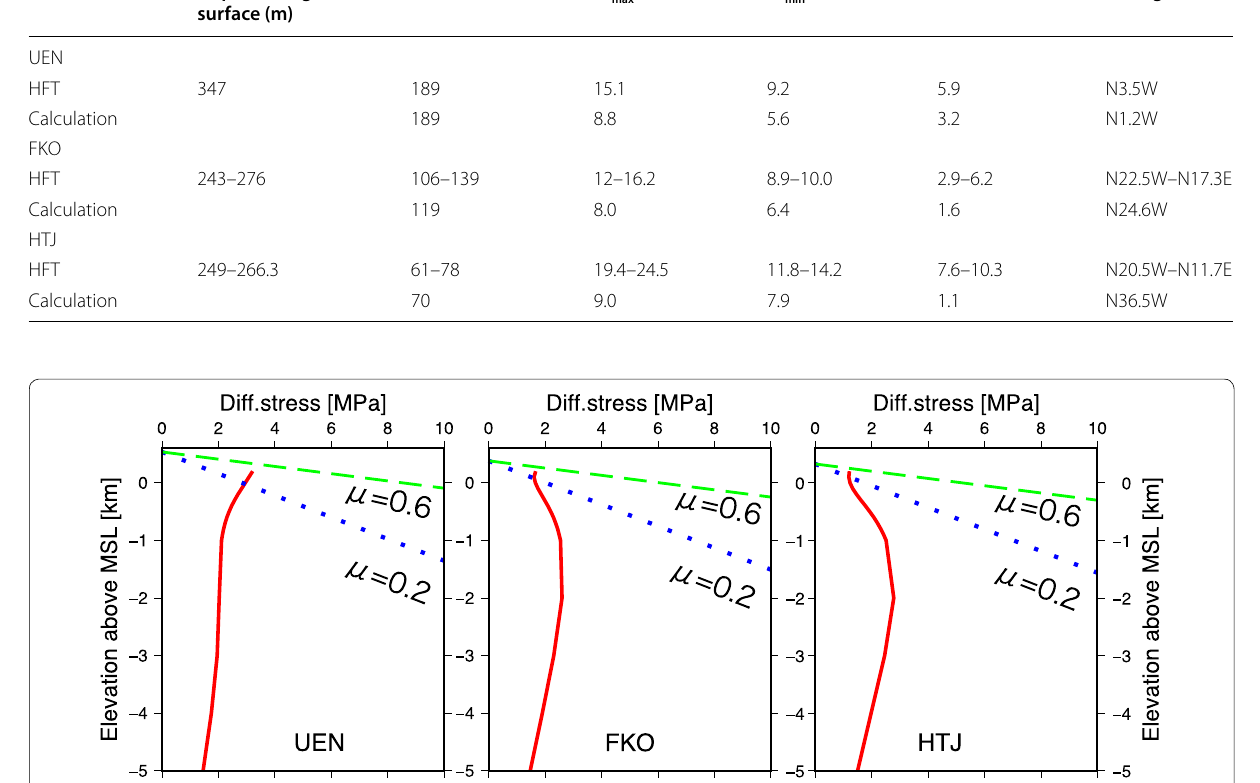
Table 2 Calculation results at depth of HFT carried out and Yamashita et al.’s (2010) results Depth from ground surface (m)